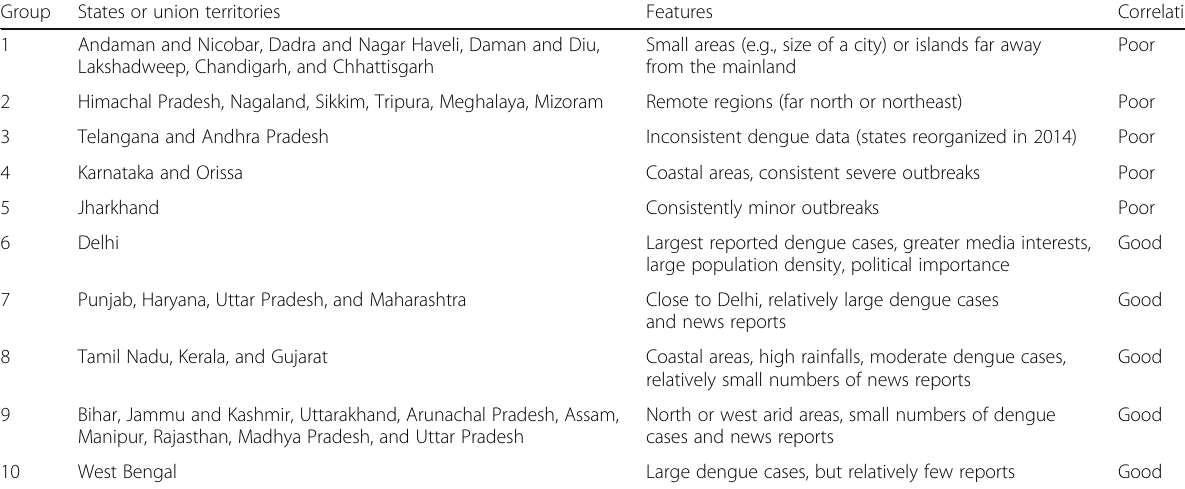
Table 1 Groups and features of states and union territories Group States or union